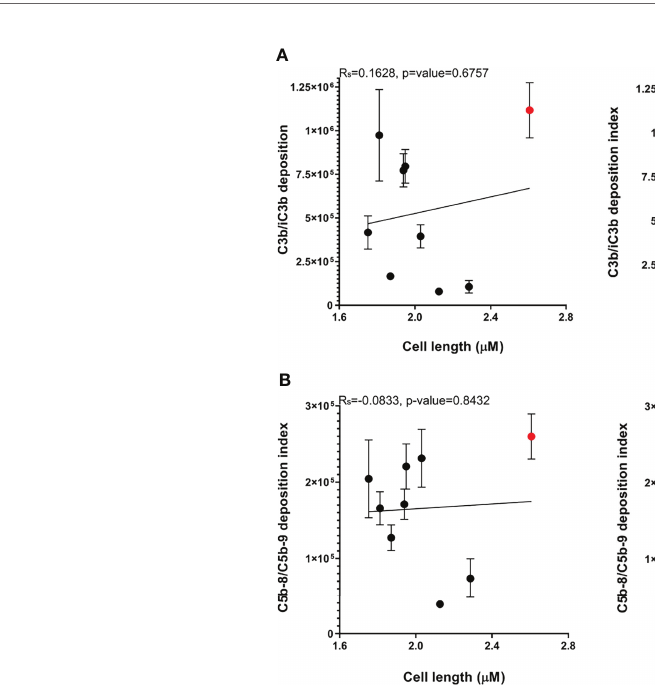
FIGURE 7 | Bacterial cell length varies between A. baumannii clinical strains but does not correlate with C3b/iC3b, or C5b-8/C5b-9 deposition. The cell length measurements of a minimum of 400 representative bacteria of the nine A. baumannii strains were determined. (A) Correlation between median cell length and C3b/ iC3b deposition in the nine clinical strains (left panel) or excluding the NPRC-AB20 strain (right panel) (B) Correlation between median cell length and C5b-8/C5b-9 deposition in the nine clinical strains (left panel) or excluding the NPRC-AB20 strain (right panel).